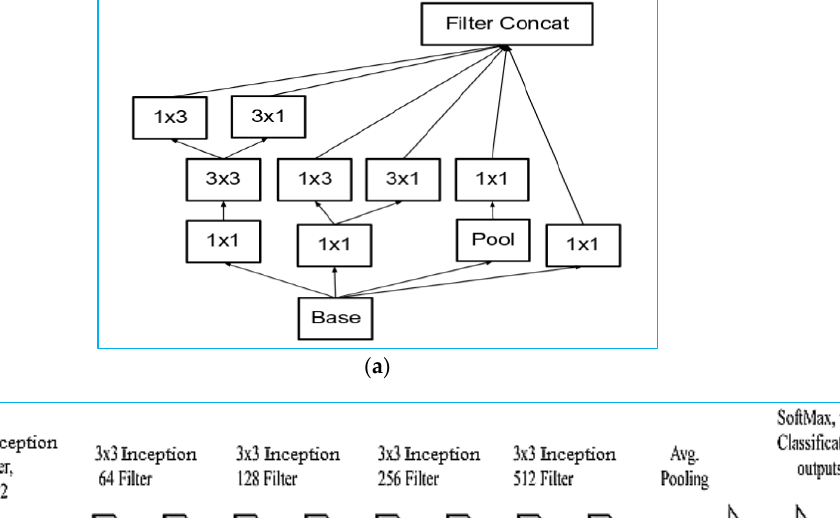
Figure 9. Registration process.